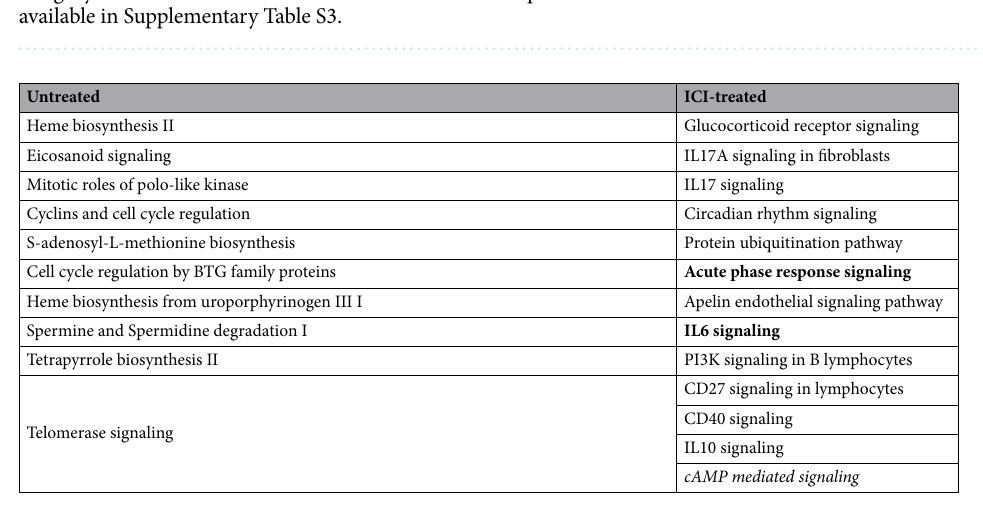
Table 2. Canonical pathways identified in the heart by the Ingenuity Pathway Analysis based on the comparison of stressed with non-stressed untreated rats (4 rats/group), and those stressed and unstressed treated with ICI118,551 (4 rats/group). Bold shading indicates prediction of activation and italics indicates prediction of inhibition. A list with additional information is available in Supplementary Table